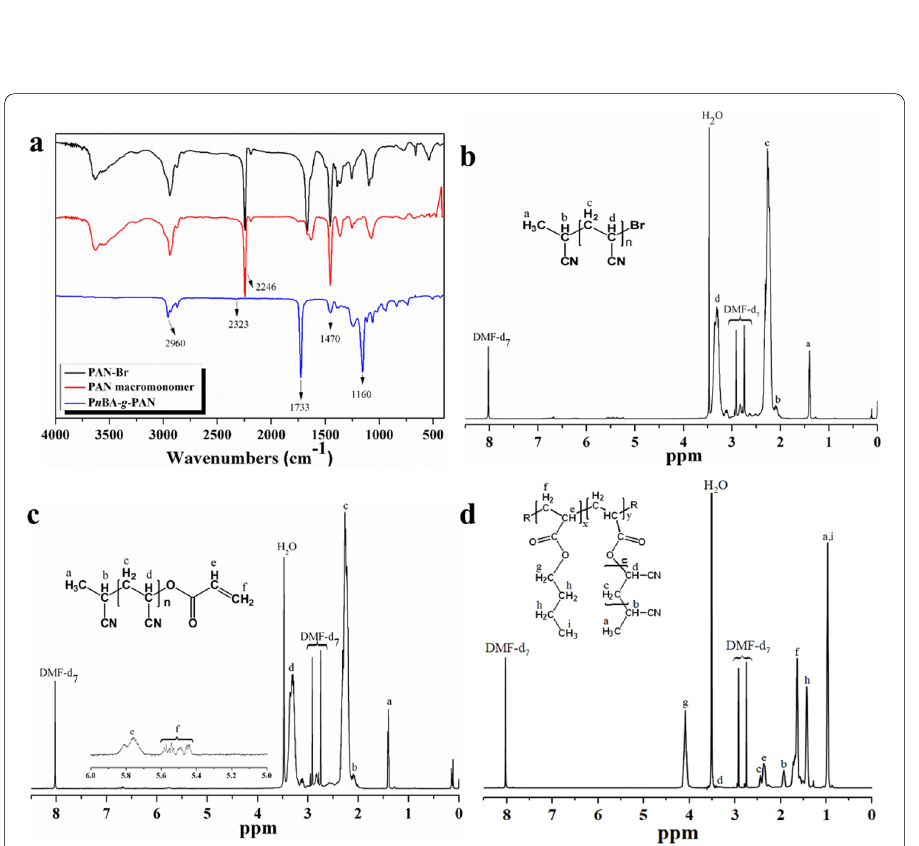
Fig. 1 a FTIR spectra of PAN-Br, PAN macromonomer and P n BA- g -PAN; 1 H NMR spectra of b PAN-Br, c PAN macromonomer and (d) P n BA- g